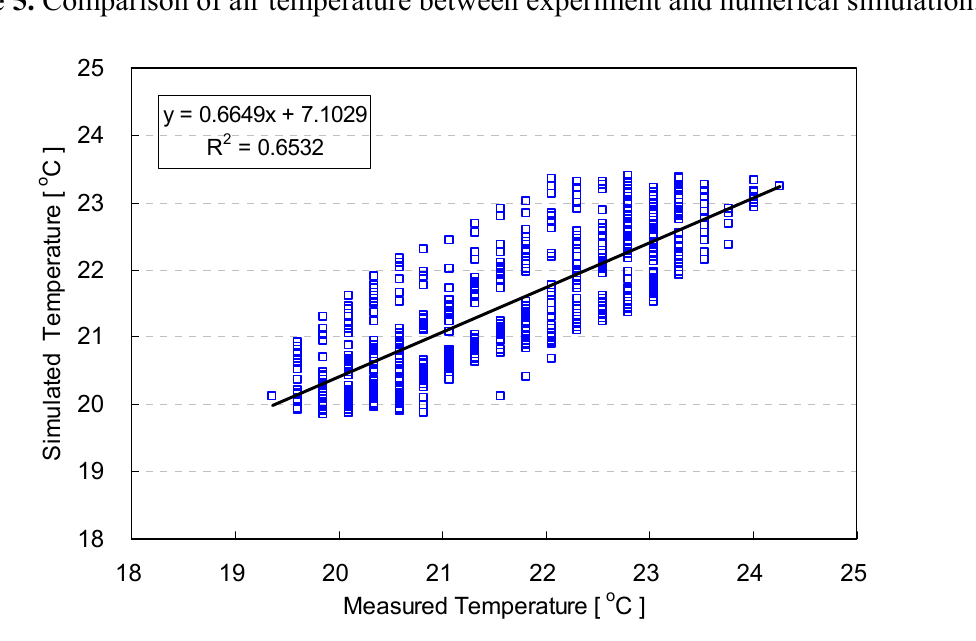
Figure 5. Comparison of air temperature between experiment and numerical simulation.